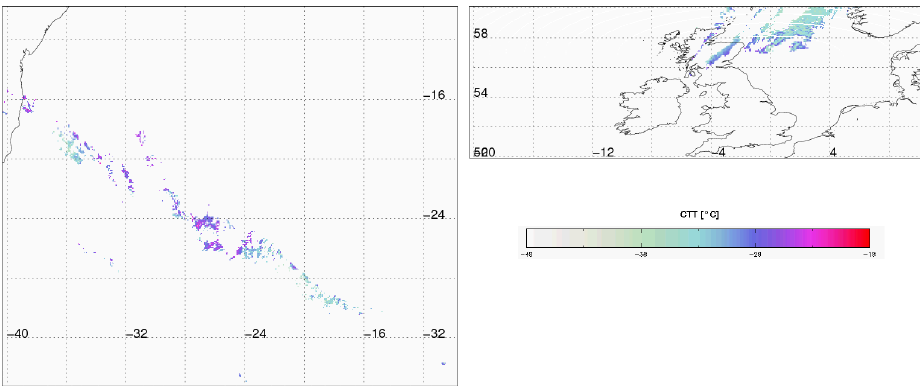
Fig. 5. High opaque clouds with liquid water on top; left: over ocean (10 October 2009, 11:45UTC)); right: British Isles land and ocean (20 October 2009, 11:45UTC), only pixels with CTT > − 38 ◦